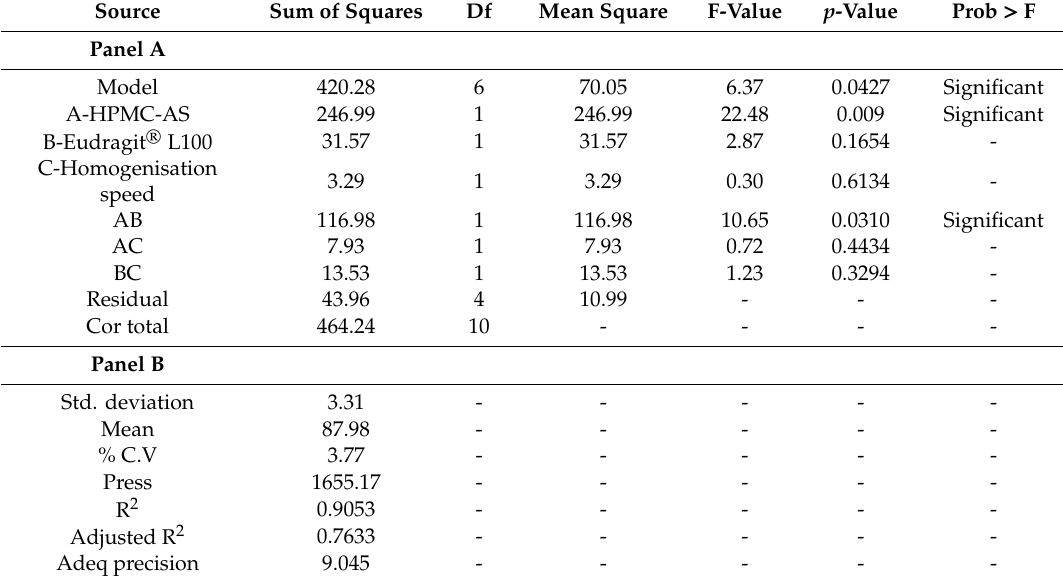
Table 6. ANOVA data for a 2FI model (partial sum of squares—Type III) for % INH released in pH 6.8, 0.1 M phosphate bu ff er at 24 h.